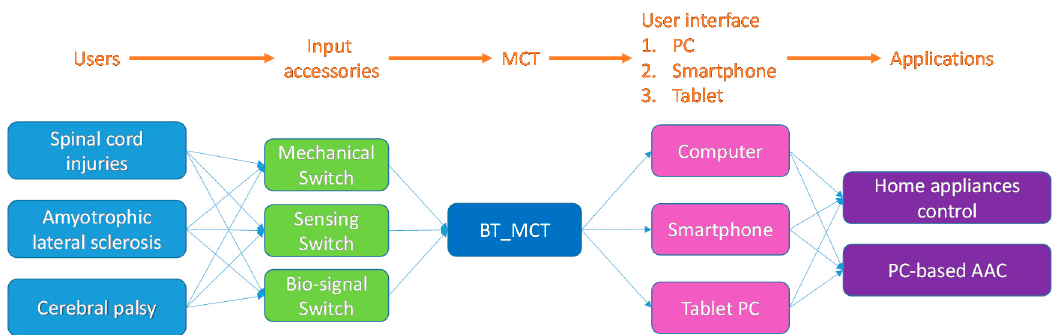
Figure 1. The architecture of the wireless home assistive system (WHAS).